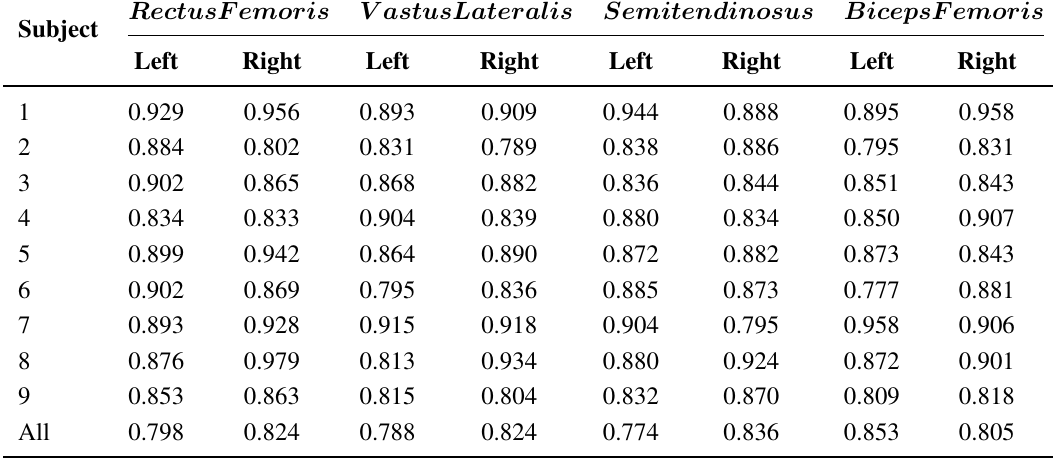
Table 3. The coefficient of determination R 2 for subject-specific, as well as general random forest regression models for predicting blood lactate concentration.